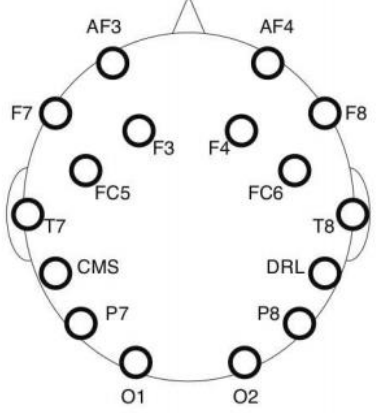
Figure 3. EEG data channel placement.